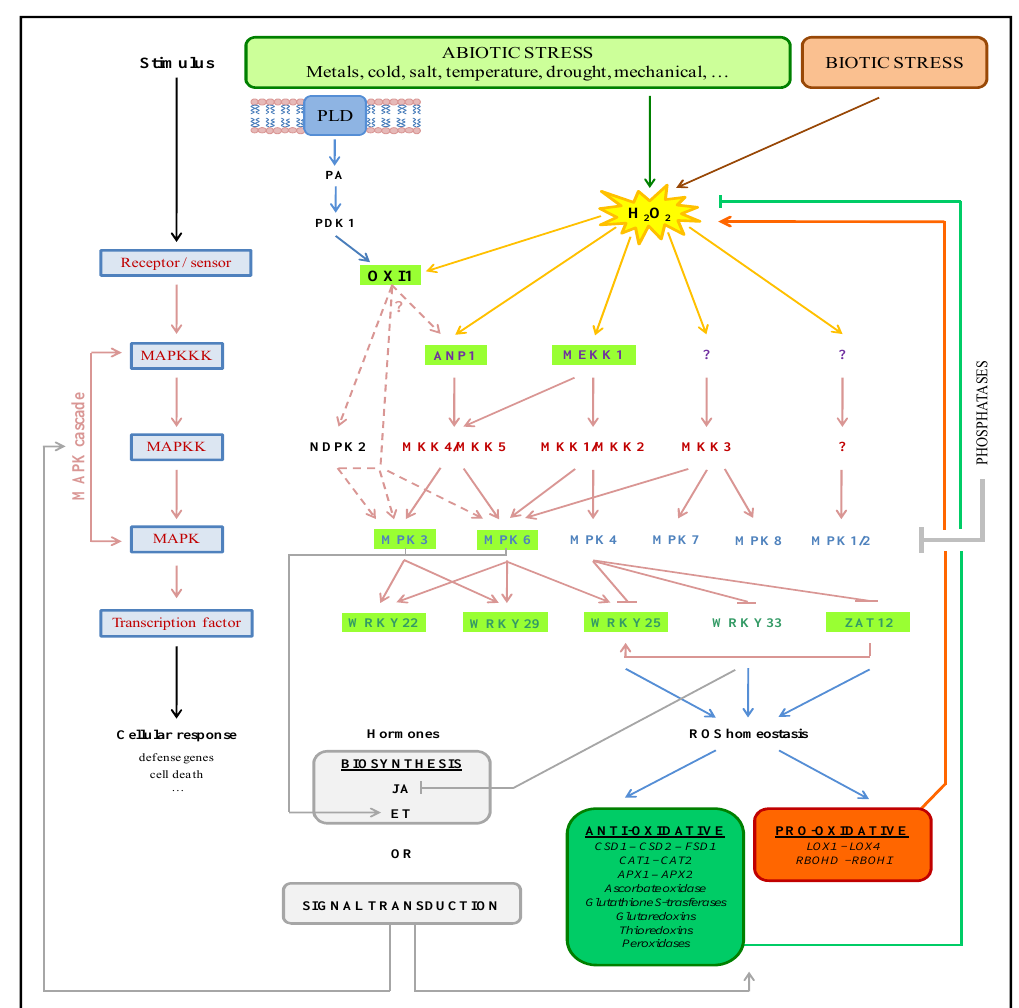
Figure 1. Overview of the different MAPK cascades known to function in stress responses as well as their regulation and possible downstream outcomes (signaling components involved in metal stress are highlighted in green). Production of ROS is a common phenomenon between different biotic and abiotic stresses. In particular H intra- and intercellular signaling molecule activating MAPK cascades. Via lipid signaling or phosphorylation of OXI1, ROS production can be linked to MAPK activation. MAPK signaling pathways induce gene expression of stress-responsive genes through the activation of transcription factors. On one hand, MAPK cascades influence the cellular redox status by activating gene expression of antioxidative or pro-oxidative enzymes. In this way, MAPK signaling can attenuate or amplify the initial ROS signal. On the other hand, MAPKs interfere with hormone signaling and biosynthesis leading to activation of downstream stress responses. Inactivation of MAPK pathways occurs through phosphatases, which dephosphorylate MAPKs, resulting in the disruption of the MAPK signal and are therefore important in the regulation of downstream